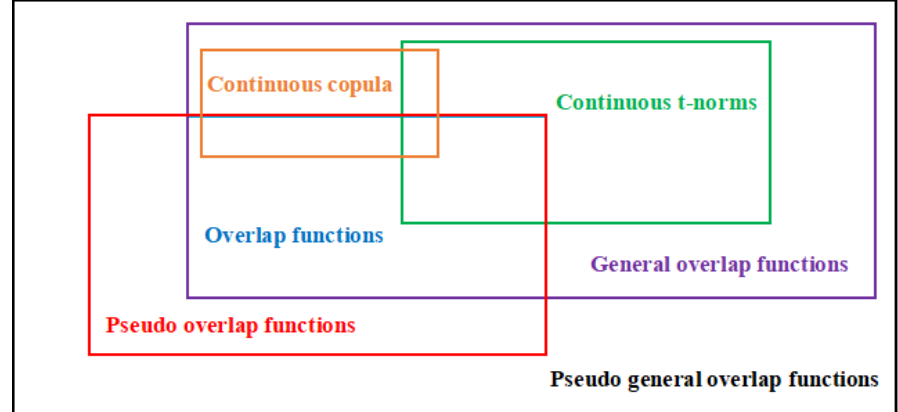
Figure 1. Relationship of the several kinds of functions considered in the